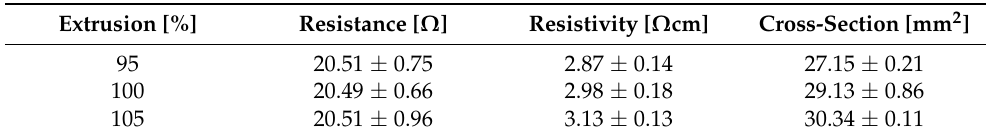
Table 1. Resistance and resistivity values with geometry of the samples printed with different extrusion settings.